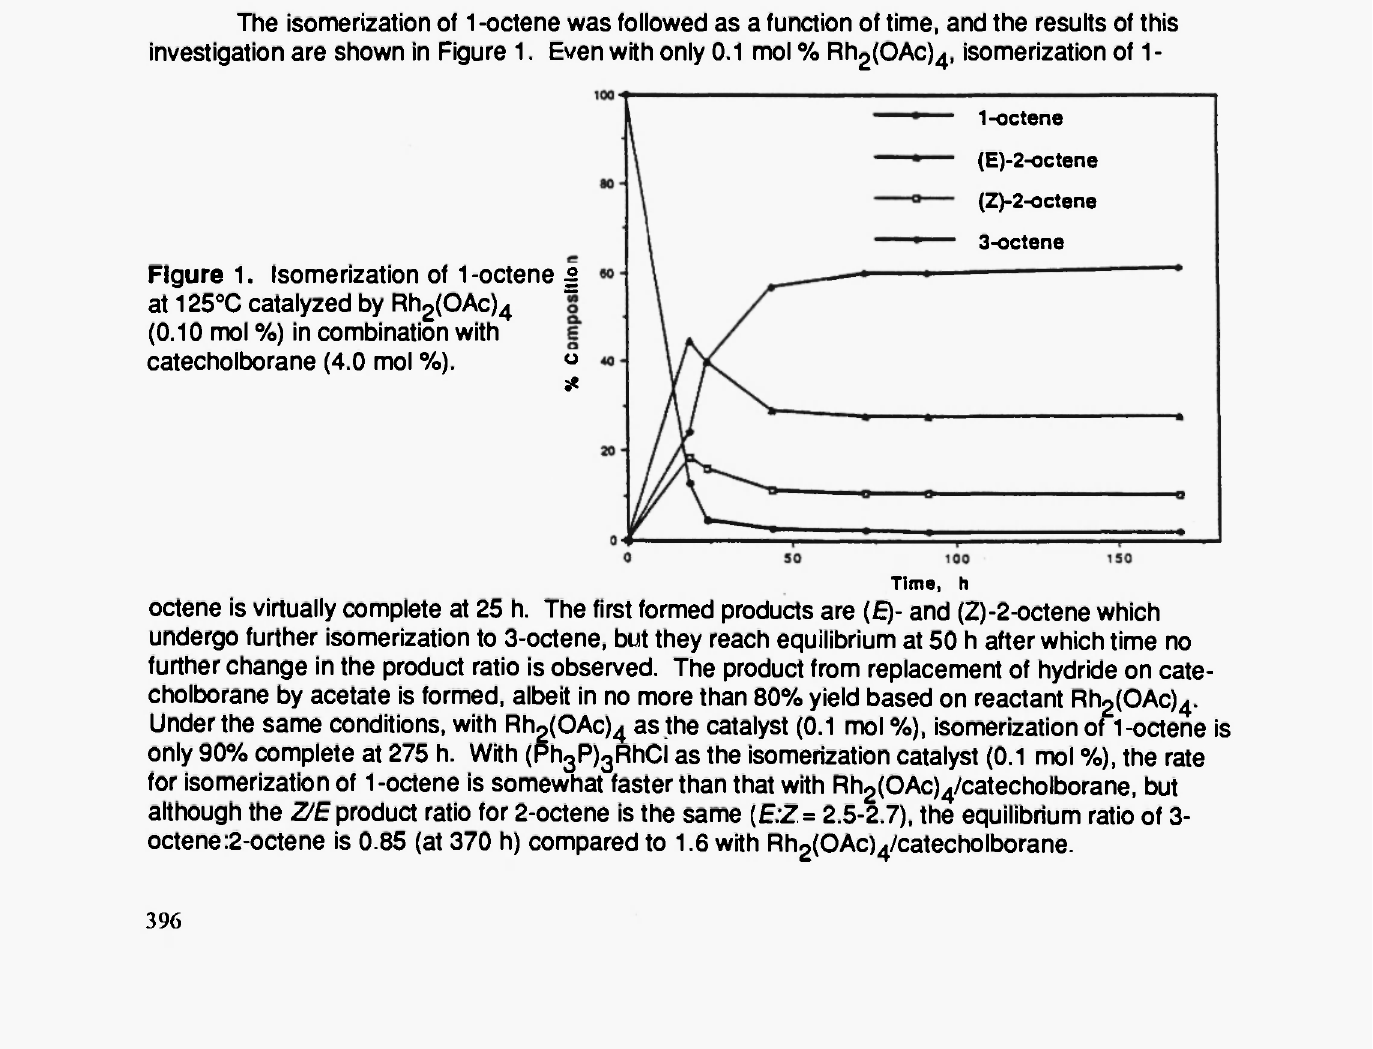
Figure 1. Isomerization of 1 -octene | at 125°C catalyzed by Rh (0.10 mol %) in combination with catecholborane (4.0 mol